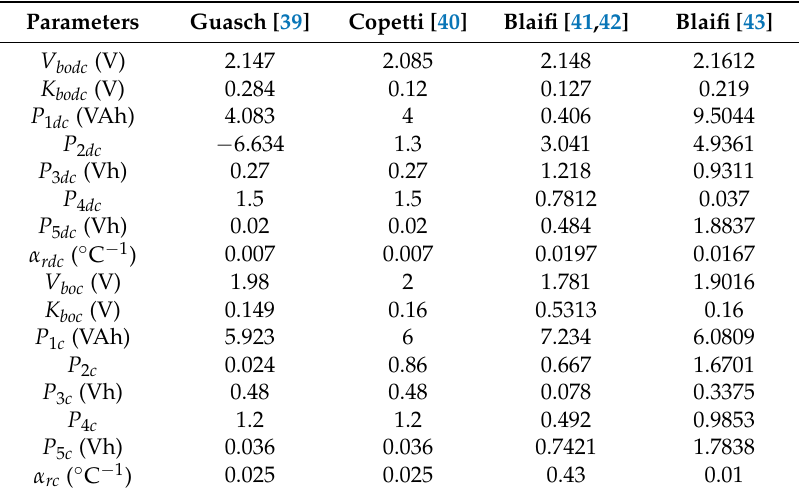
Table 1. Nominal values of the identified parameters by some